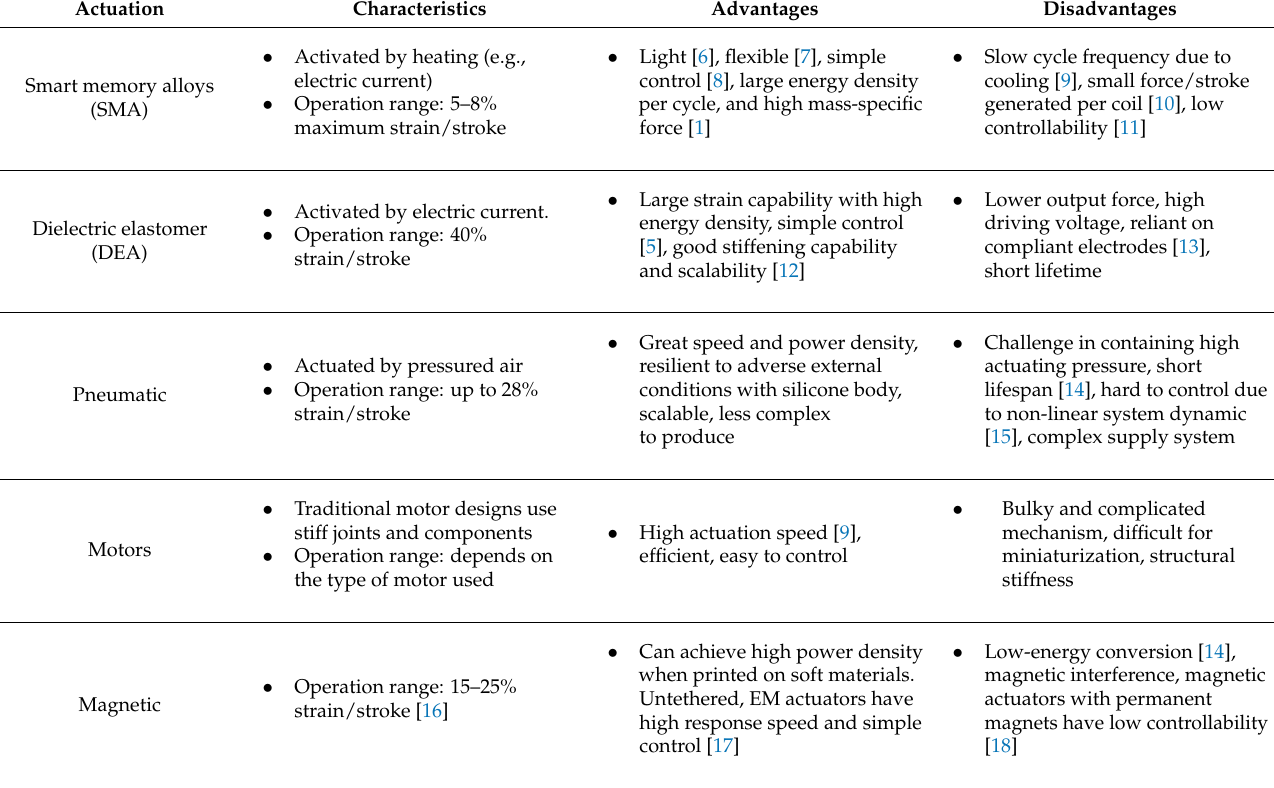
Table 1. Summary of actuators used in literature for compliant